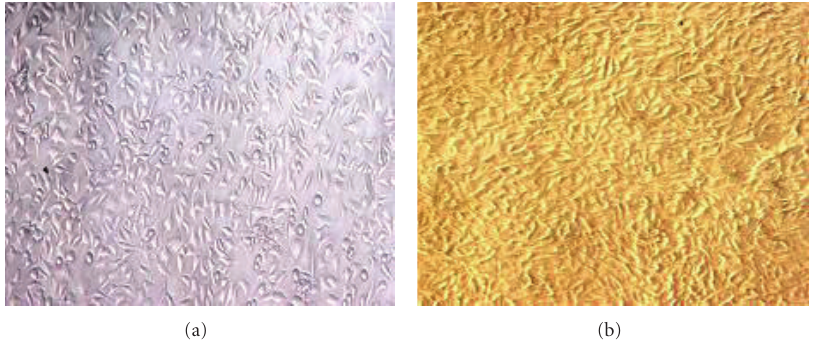
Figure 5: Fibroblast cells growth on the (Comfeel) control sample (100 × ): (a) After 24 hours; (b) After 48 hours.